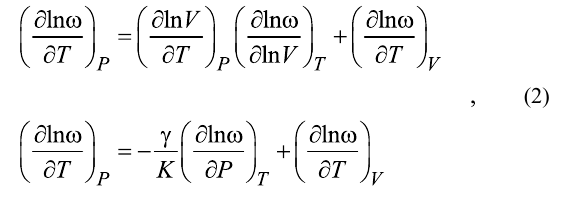
Figure 4: (a) Deconvoluted XPS spectra for Pt and (b) Se elements. lower wavenumbers as the temperature increases from 100 K to 506 K. The Raman modes E g and A 1g for PtSe 2 behave linearly